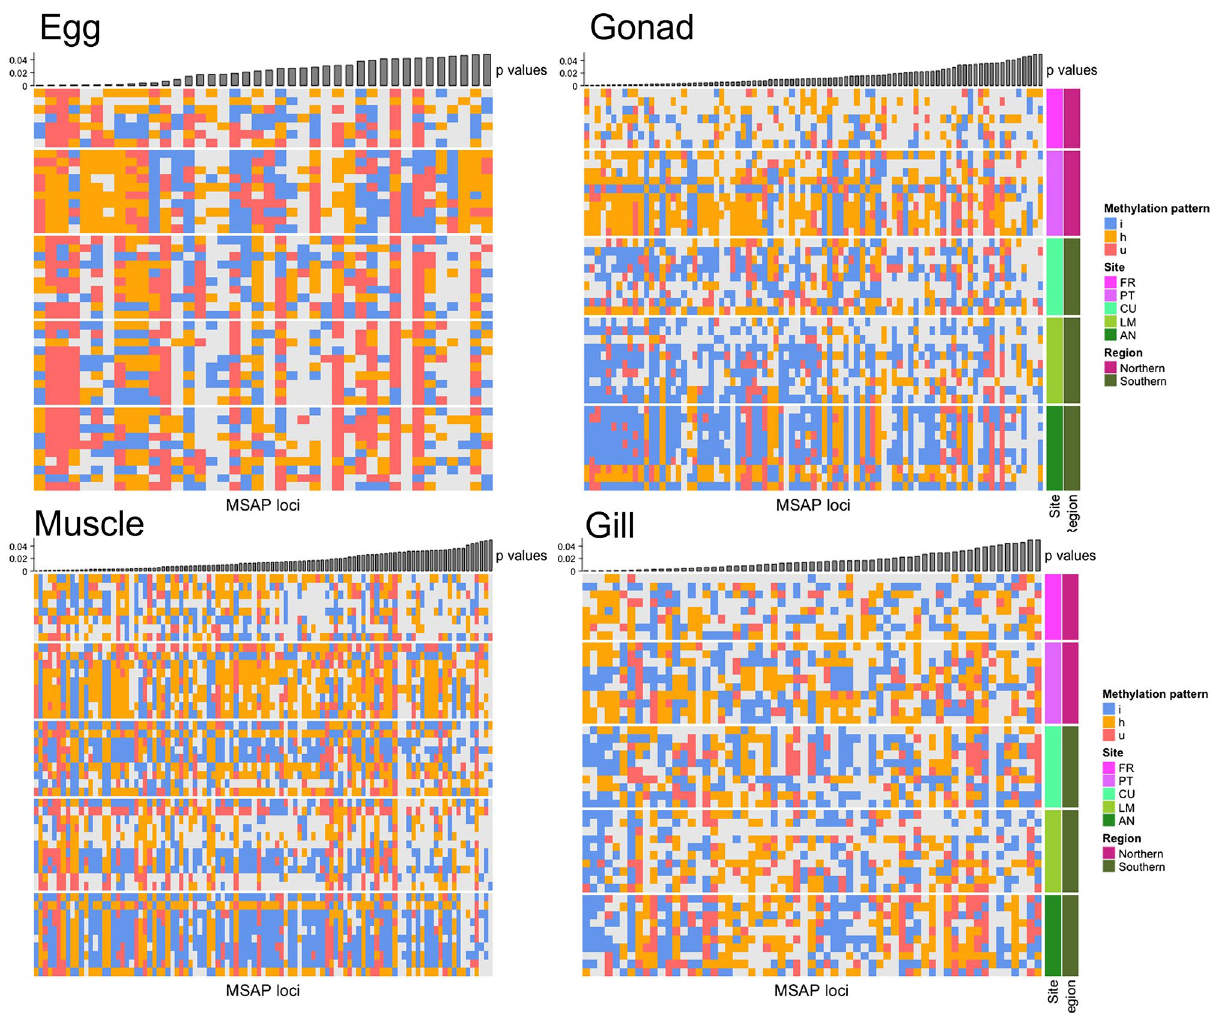
Figure 5. Heatmaps of highly differentially methylated MSL for each adult tissue and eggs. Specimens (rows) and loci (columns) were clustered by the average linkage method. These selected MSL are the most highly differentially methylated loci identified by Chi-squared test after FDR. p -values are given on top of each figure. Regions and Site are shown at right side of the heatmap. The colours in the heatmap indicate patterns for the three different methylated states (h: hemimethylated, i: inner cytosine methylation, u: unmethylated) and N/A for uninformative sites associated with each